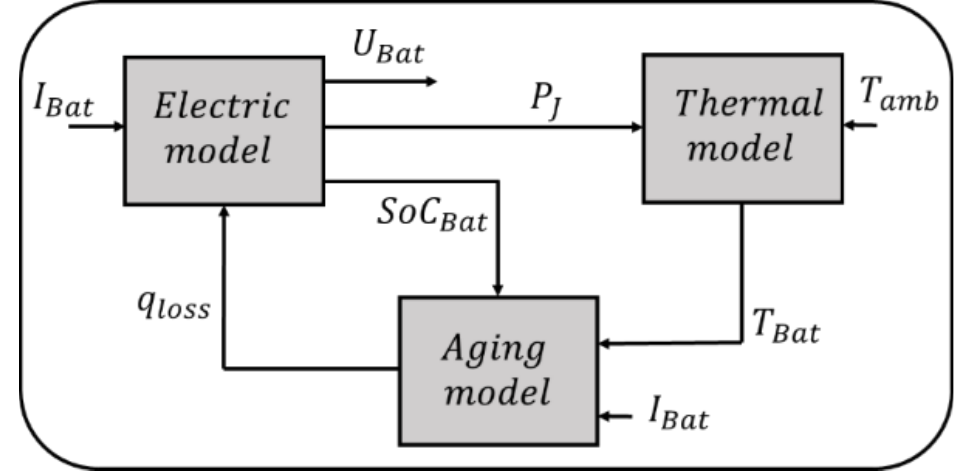
Figure 4. Coupling of the battery electrothermal and aging model.